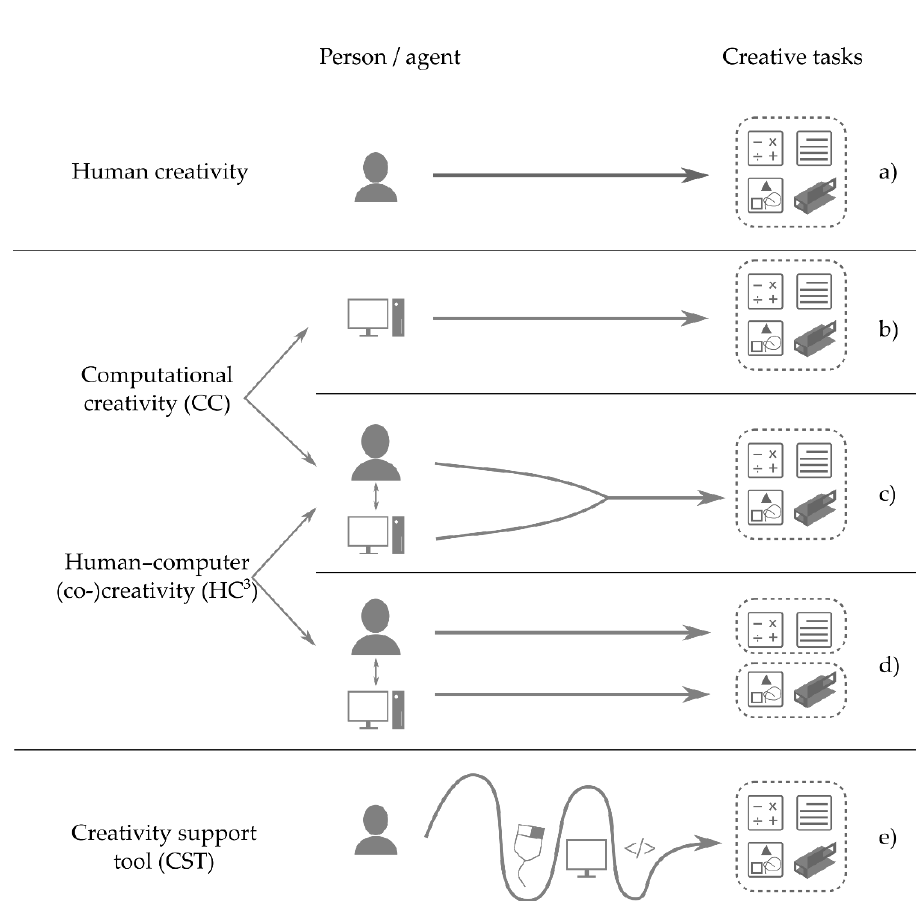
Figure 1. The relationships between humans and computers in the three different levels of computational creativity (CC, HC 3 and CST).